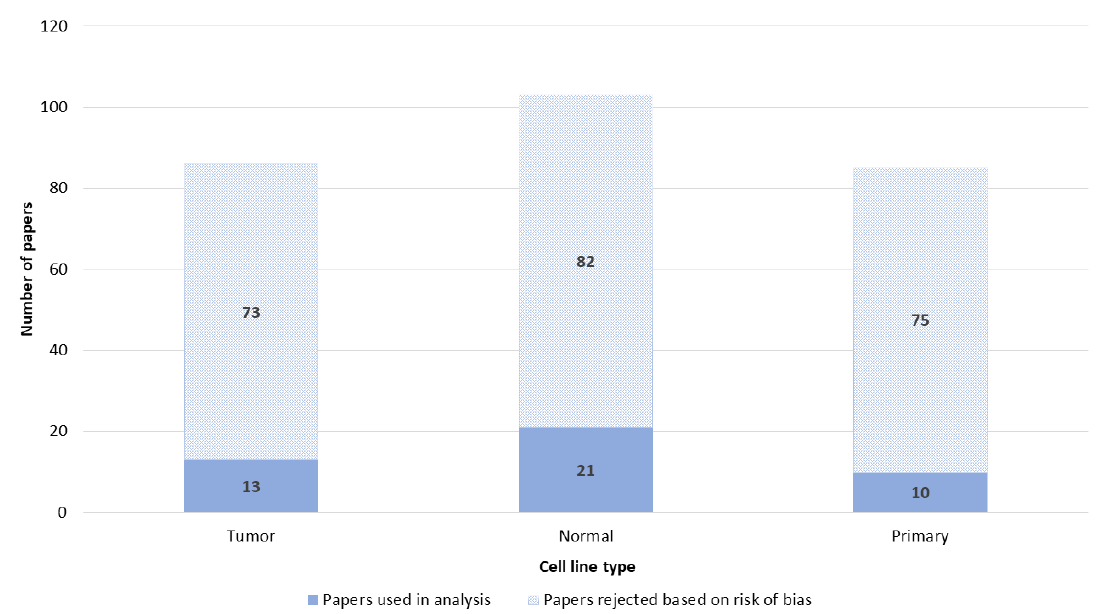
Figure 10. NA concentration. NR—not reported.